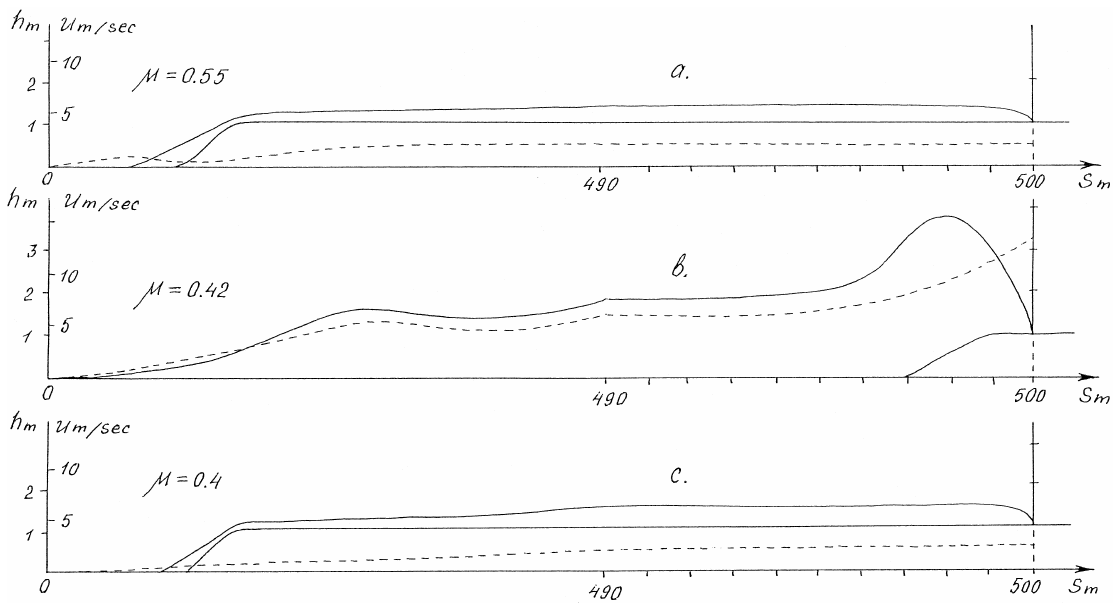
Figure 9. Further examples of simulations with the full model (case 13–15 in Table 3), showing the distributions of new-snow depth and flow depth (full lines), and velocity (dashed lines) when the avalanche front reaches S f = 500m. Note the change of horizontal scale at S = 490m. ( a ) Slowly moving, non-eroding avalanche with dry-friction coefficient µ = 0.55. ( b ) “Ignited” avalanche with µ = 0.42. ( c ) With µ = 0.40, the avalanche behaves similarly as in the case µ = 0.55 (panel